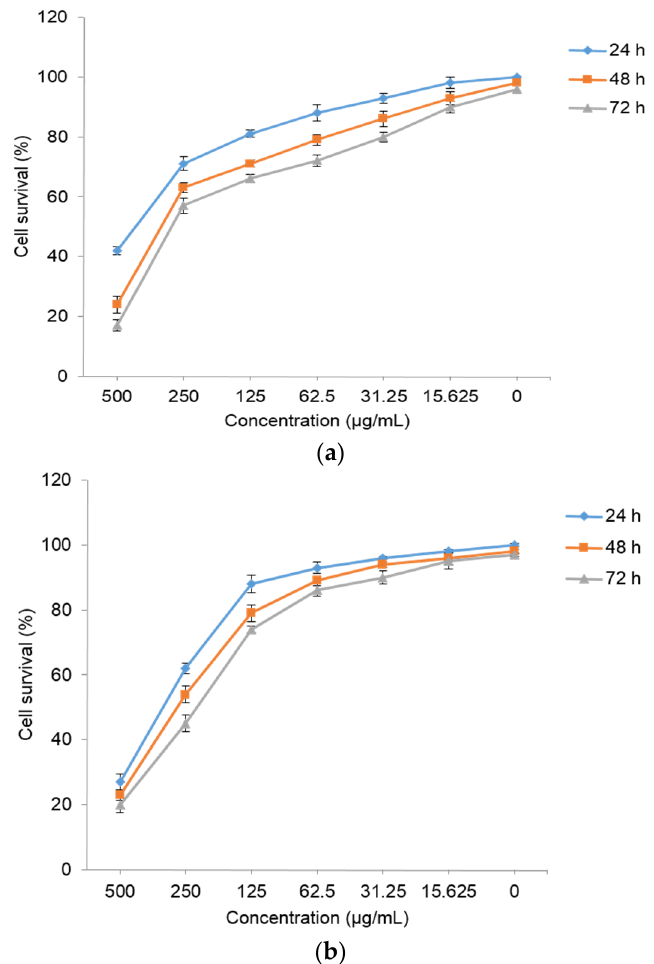
Figure 6. ( a ) The cytotoxic effect of synthesized CuFe 2 O 4 nanoparticles on MCF ‐ 7 cells (human breast cancer cell line). Each value is expressed as a mean of ± S.D ( n = 3); ( b ) The cytotoxic effect of synthesized ZnFe 2 O 4 nanoparticles on MCF ‐ 7 cells (human breast cancer cell line).